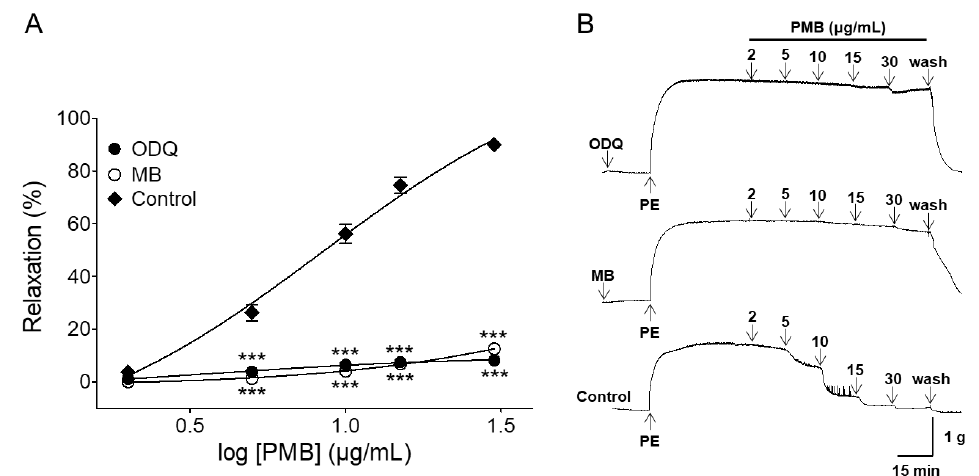
Figure 3. Concentration-dependent relaxation effect of PMB (2–30 μg/mL) on phenylephrine (PE, 1 μM)-pre-contracted endothelium-intact aortic rings in the presence and absence (control) of 1 H -[1,2,4]oxadiazolo[4,3-α]-quinoxalin-1-one (ODQ, 10 μM) or methylene blue (MB, 10 μM) ( A ). Representative traces under the indicated conditions ( B ). Values are expressed as mean ± SEM (n = 6). *** p < 0.001 vs. control.